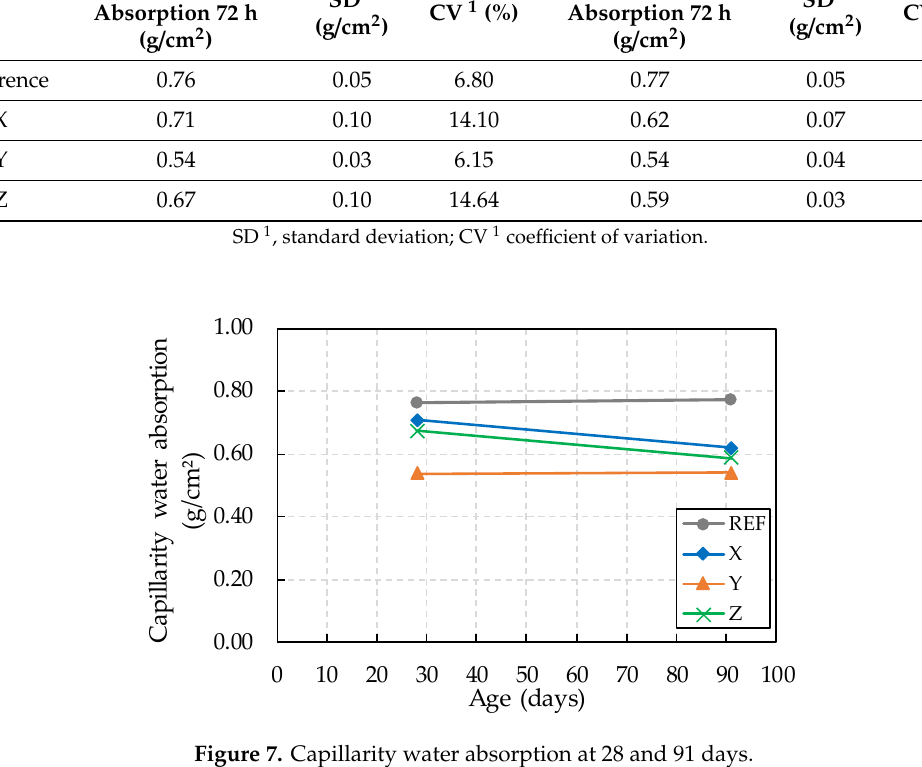
Figure 7. Capillarity water absorption at 28 and 91 days.